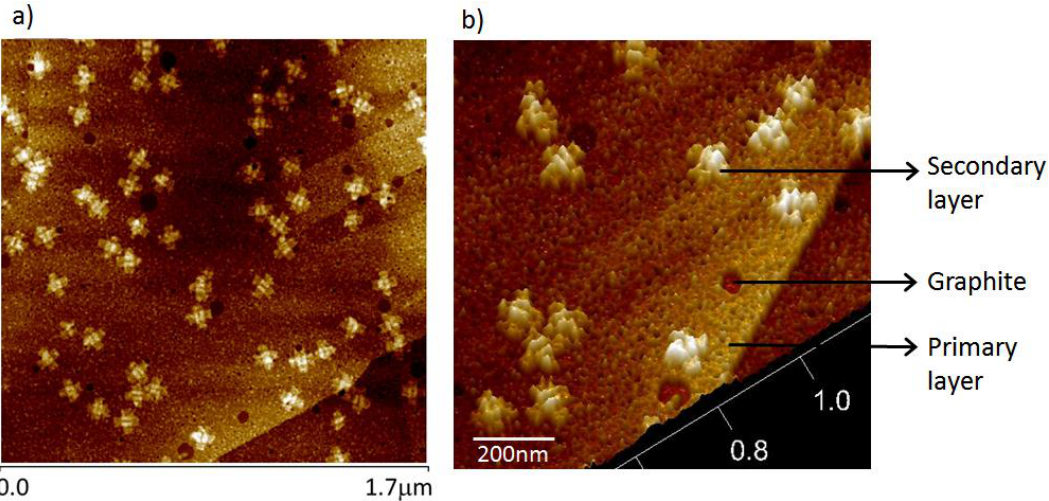
Figure 3. AFM images of cross-shaped origami deposited from a solution containing staples. Well- defined origami are visible on top of a primary layer of single-stranded DNA. Large pores are visible in the low magnification top projection image ( a ); smaller pores in this layer are visible in the 3D rendering of the bottom center portion of image ( a ) provided in image ( b